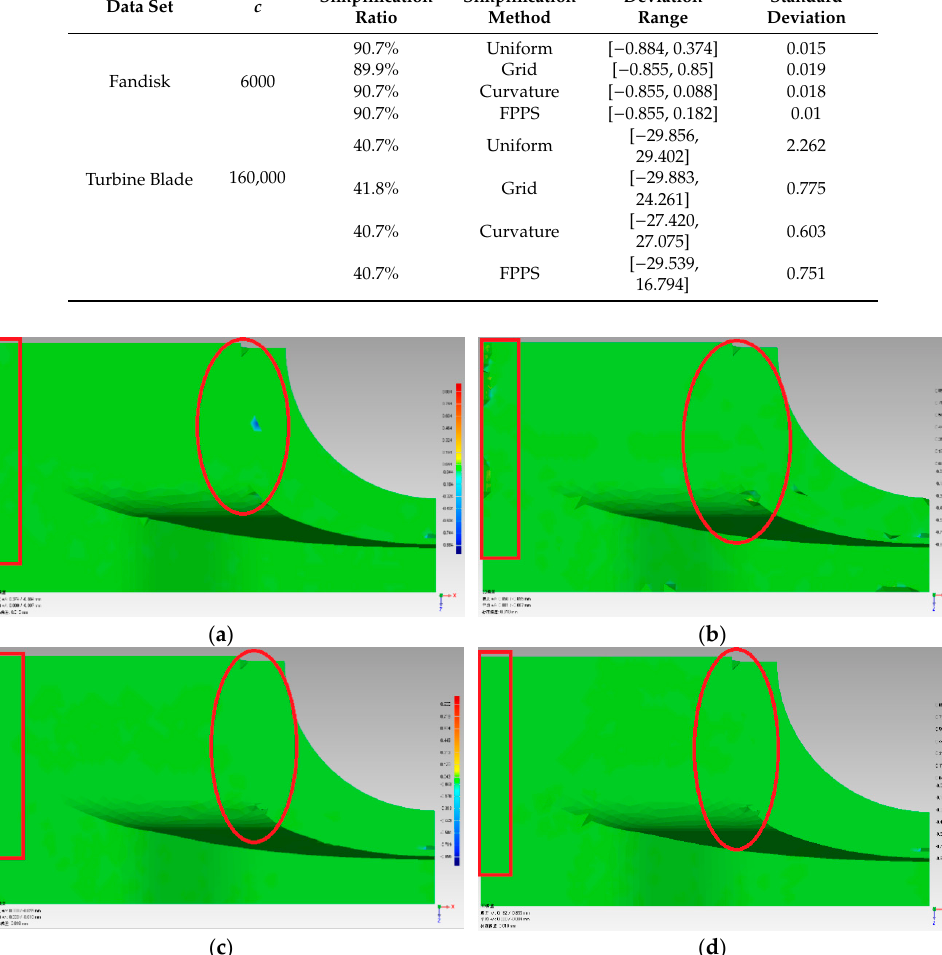
Figure 15. Simplification effect comparison of four simplification algorithms using the Fandisk data set: ( a ) uniform-based simplification algorithm; ( b ) grid-based simplification algorithm; ( c ) curvature-based simplification algorithm; ( d ) FPPS.